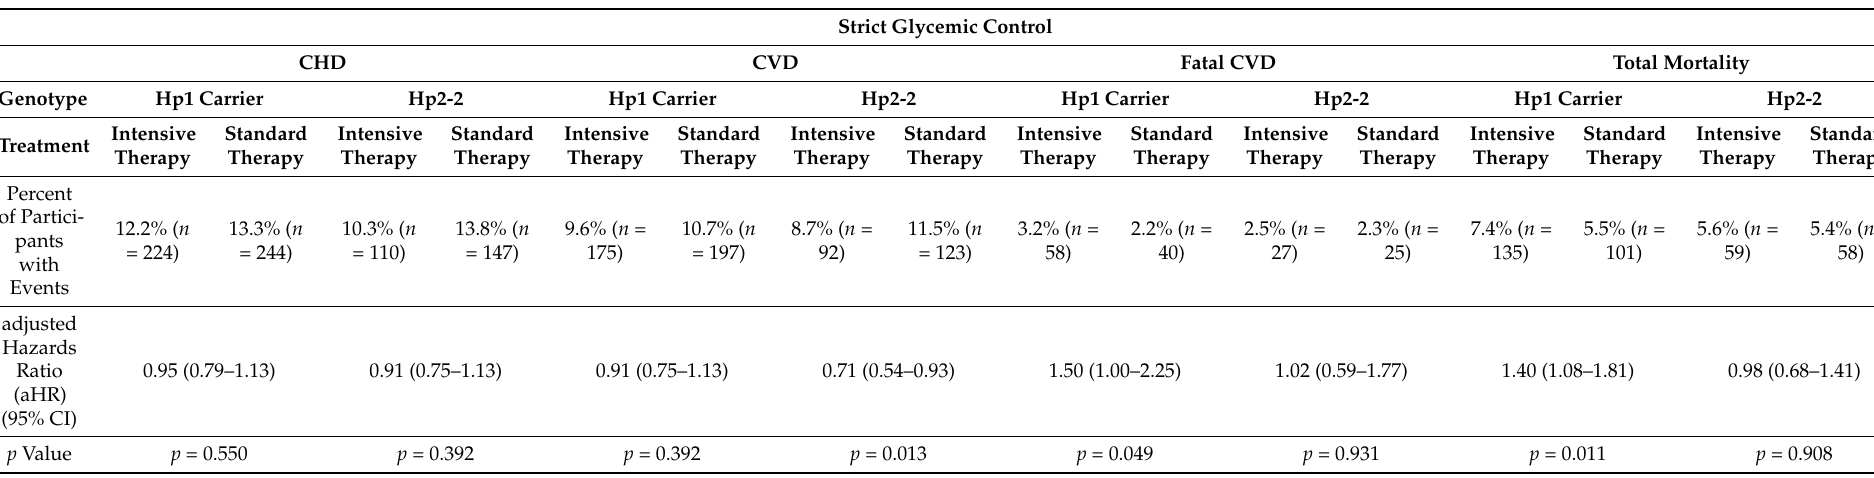
Table 2. Assessment of the effect of aggressive versus conventional glycemic control therapy on cardiovascular outcomes and total mortality in the ACCORD study